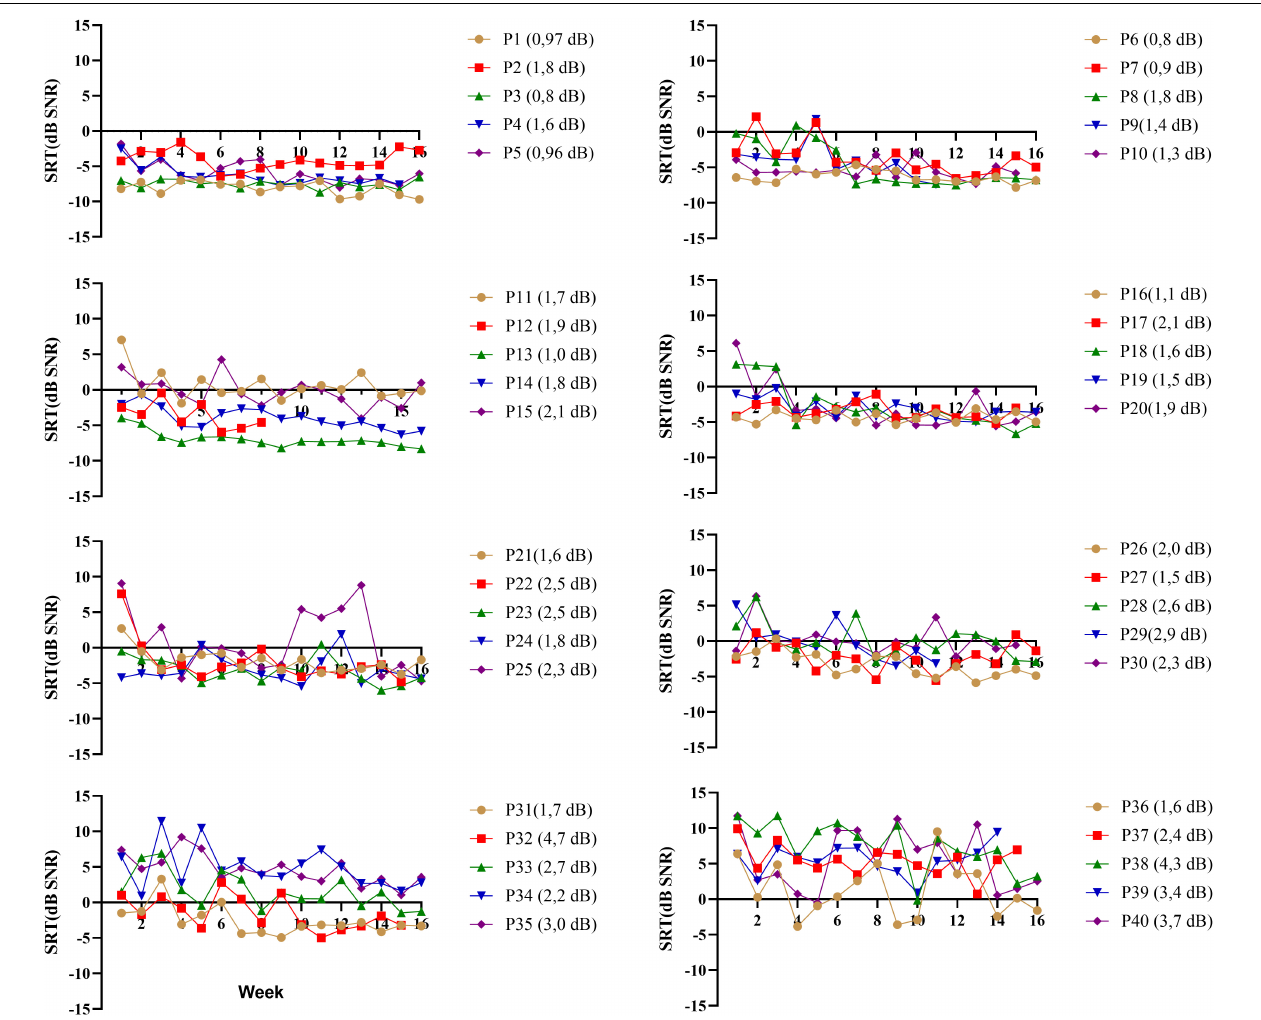
FIGURE 3 | DiN thresholds as a function of week ( n = 16) for each participant (p*) separately. Each data point is based on two estimates taken consecutively. Individual measurement errors are indicated next to the participant number and range from 0.8 dB (participant 3) to 4.7 dB (participant 32). Participants (P1-P40) are ranked according to increasing SiN.